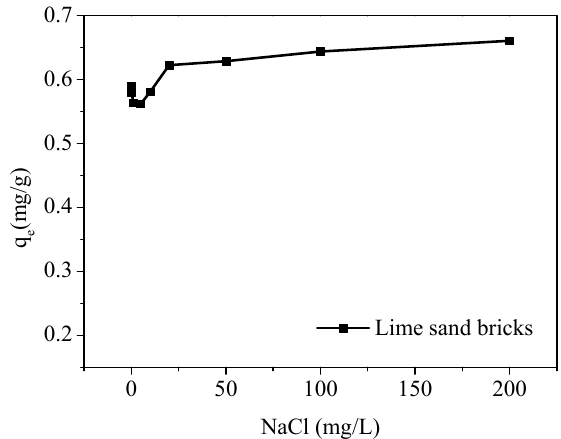
Figure 6. The effect of ionic strength (NaCl) on the adsorption of copper from aqueous solution by lime sand bricks at 25 °C ( C 0 = 5 mg /L, solid-liquid ratio = 8 g/L, stirring speed = 135 rpm, pH = 5).